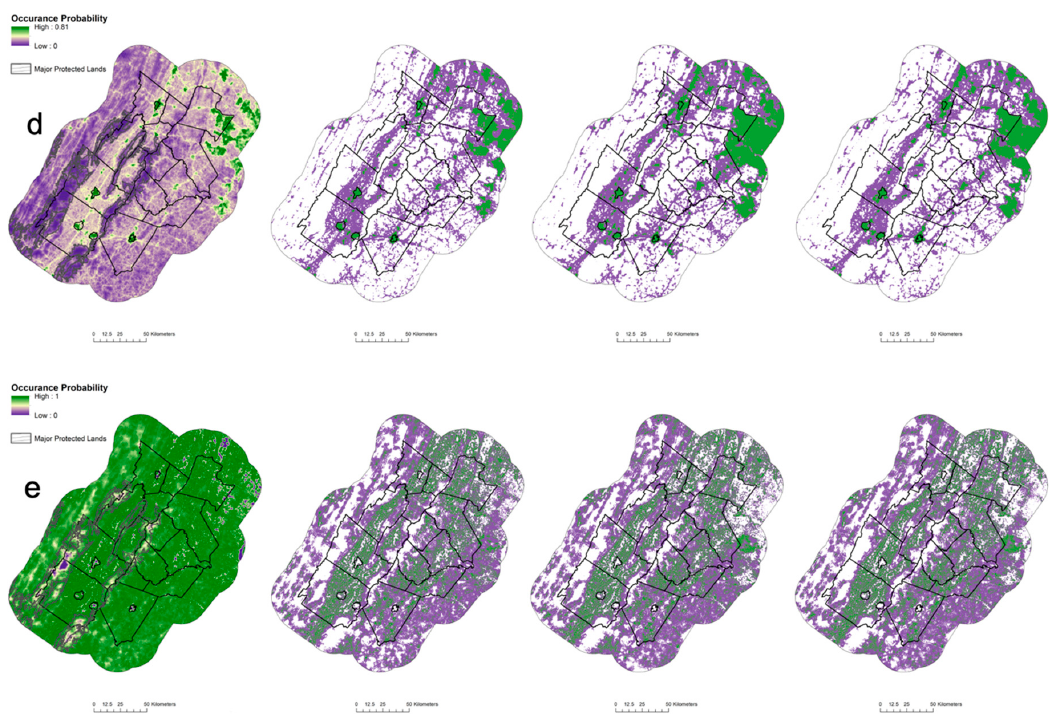
Figure 3. Predicted occupancy probabilities, core (green) and suitable (purple) habitat areas, and predicted changes over time for five representative mammals [( a ) black bear, ( b ) bobcat, ( c ) domestic cat, ( d ) red fox, and ( e ) white-tailed deer] in protected and non-protected areas during the contemporary period (2011) and under two planning scenarios into 2060. HR represents high human population growth and reactive planning, whereas S represents low population growth and strategic planning. Habitat areas were predicted from the top-ranking occupancy model with the effects of land cover and anthropogenic covariates from 1591 locations across an urban to rural gradient, northern Virginia, 2012–2018.